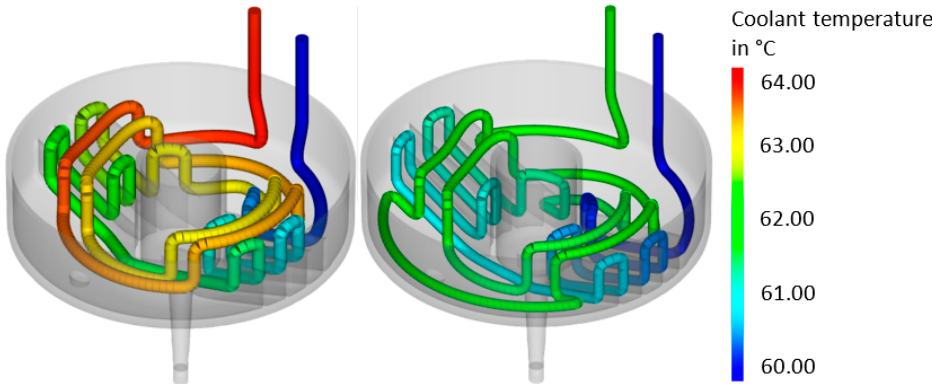
Figure 16. Temperature of the cooling medium for the initial ( left ) and optimized ( right ) close-contour cooling system.